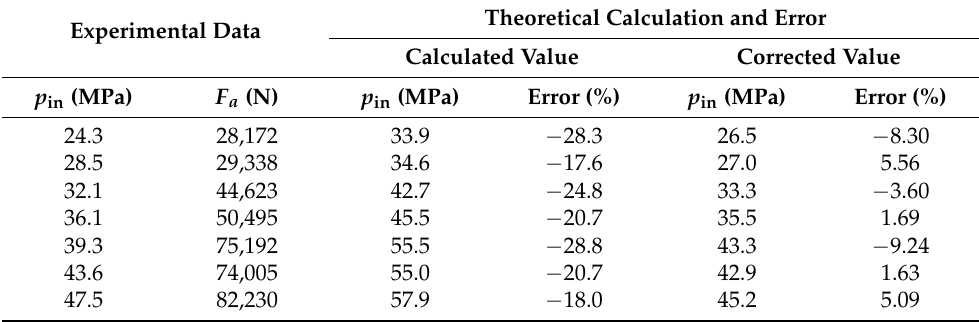
Table 7. Errors in inner cavity pressure sealing test data of connector contact sealing theory